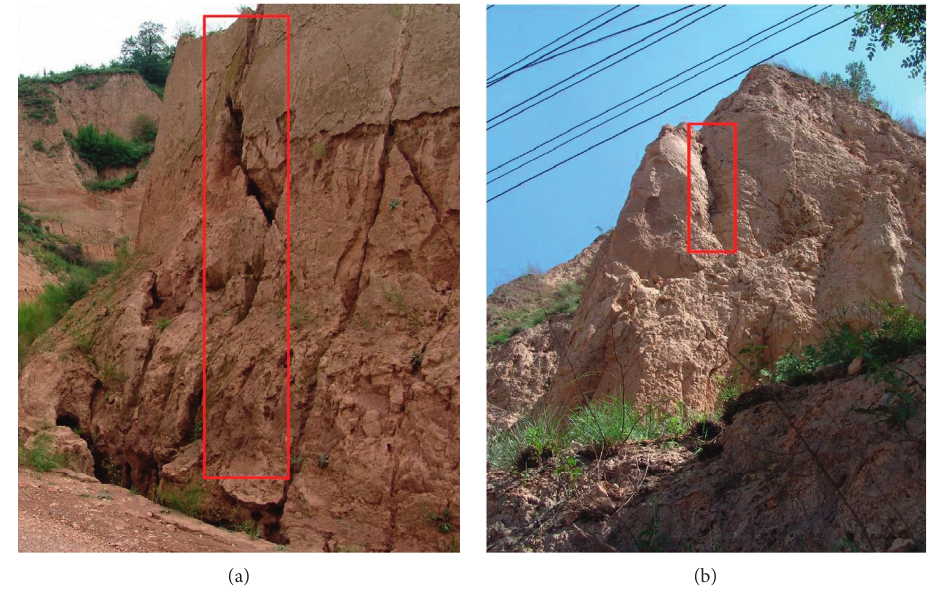
Figure 8: Cracks on Baota